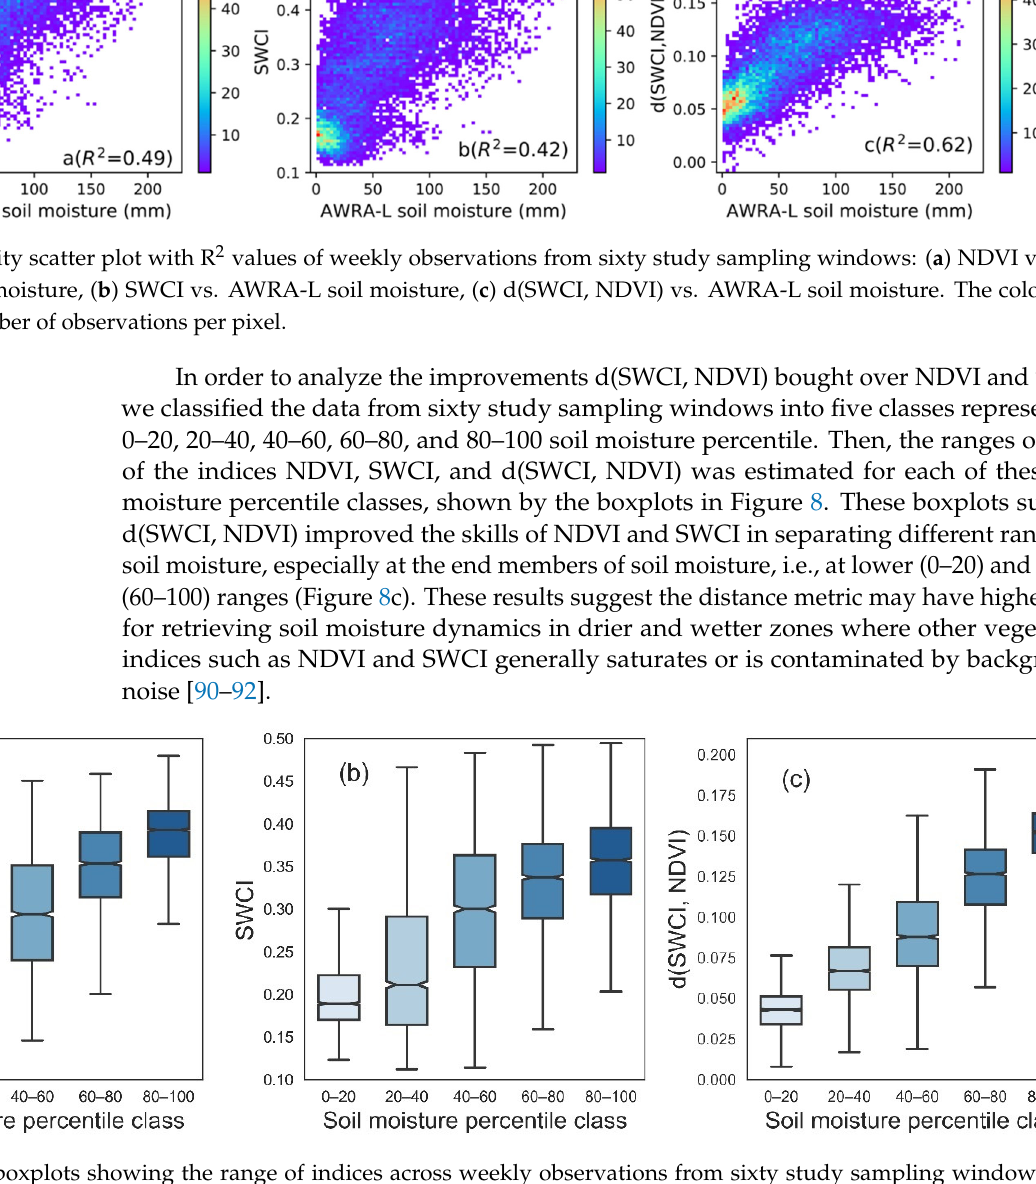
Figure 8. The boxplots showing the range of indices across weekly observations from sixty study sampling windows: ( a ) NDVI, ( b ) SWCI, ( c ) d(SWCI, NDVI) corresponding to five different soil moisture percentile classes, shown across x-axis.